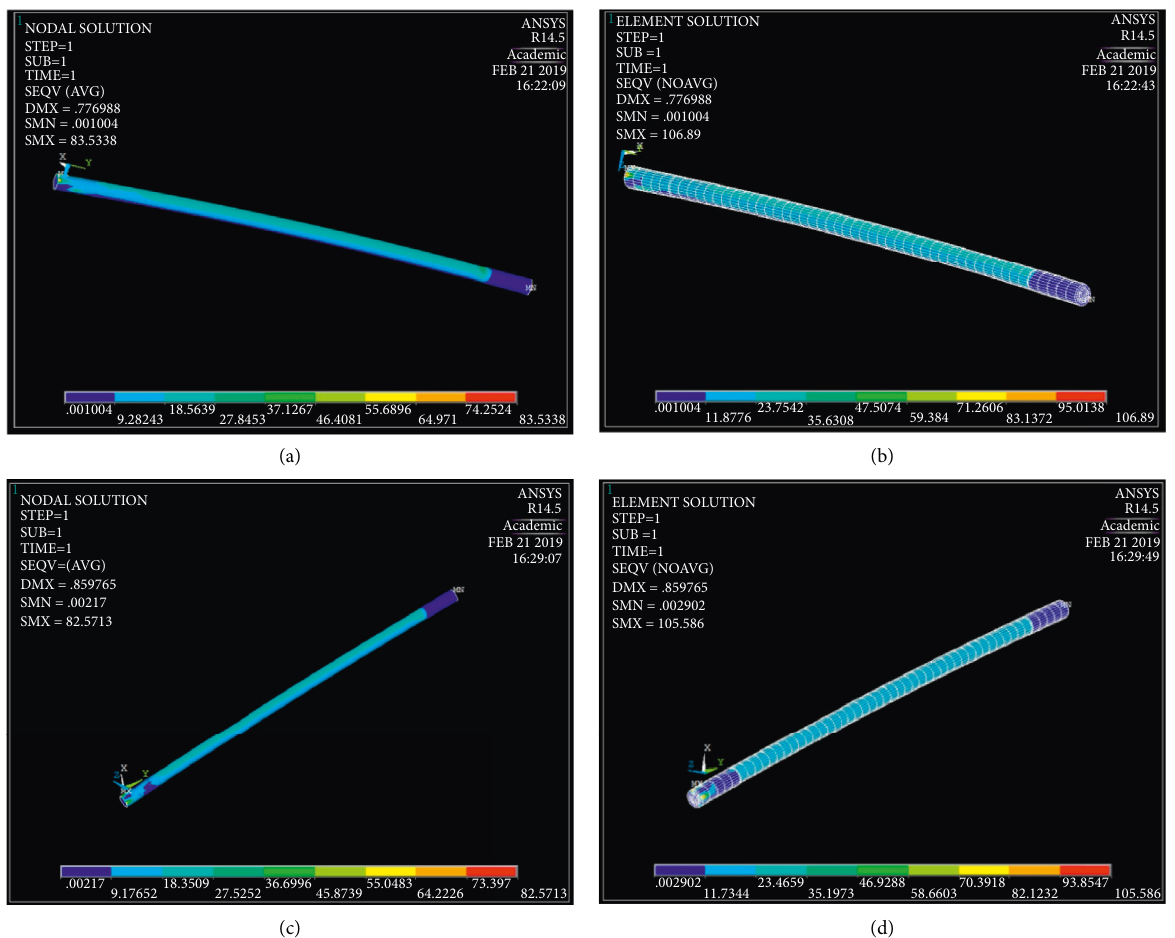
Figure 9: ANSYS simulations of (a) (b) nodal and elemental solution of stress and displacement of steel specimen, (c) (d) nodal and elemental solution of stress and displacement of aluminum